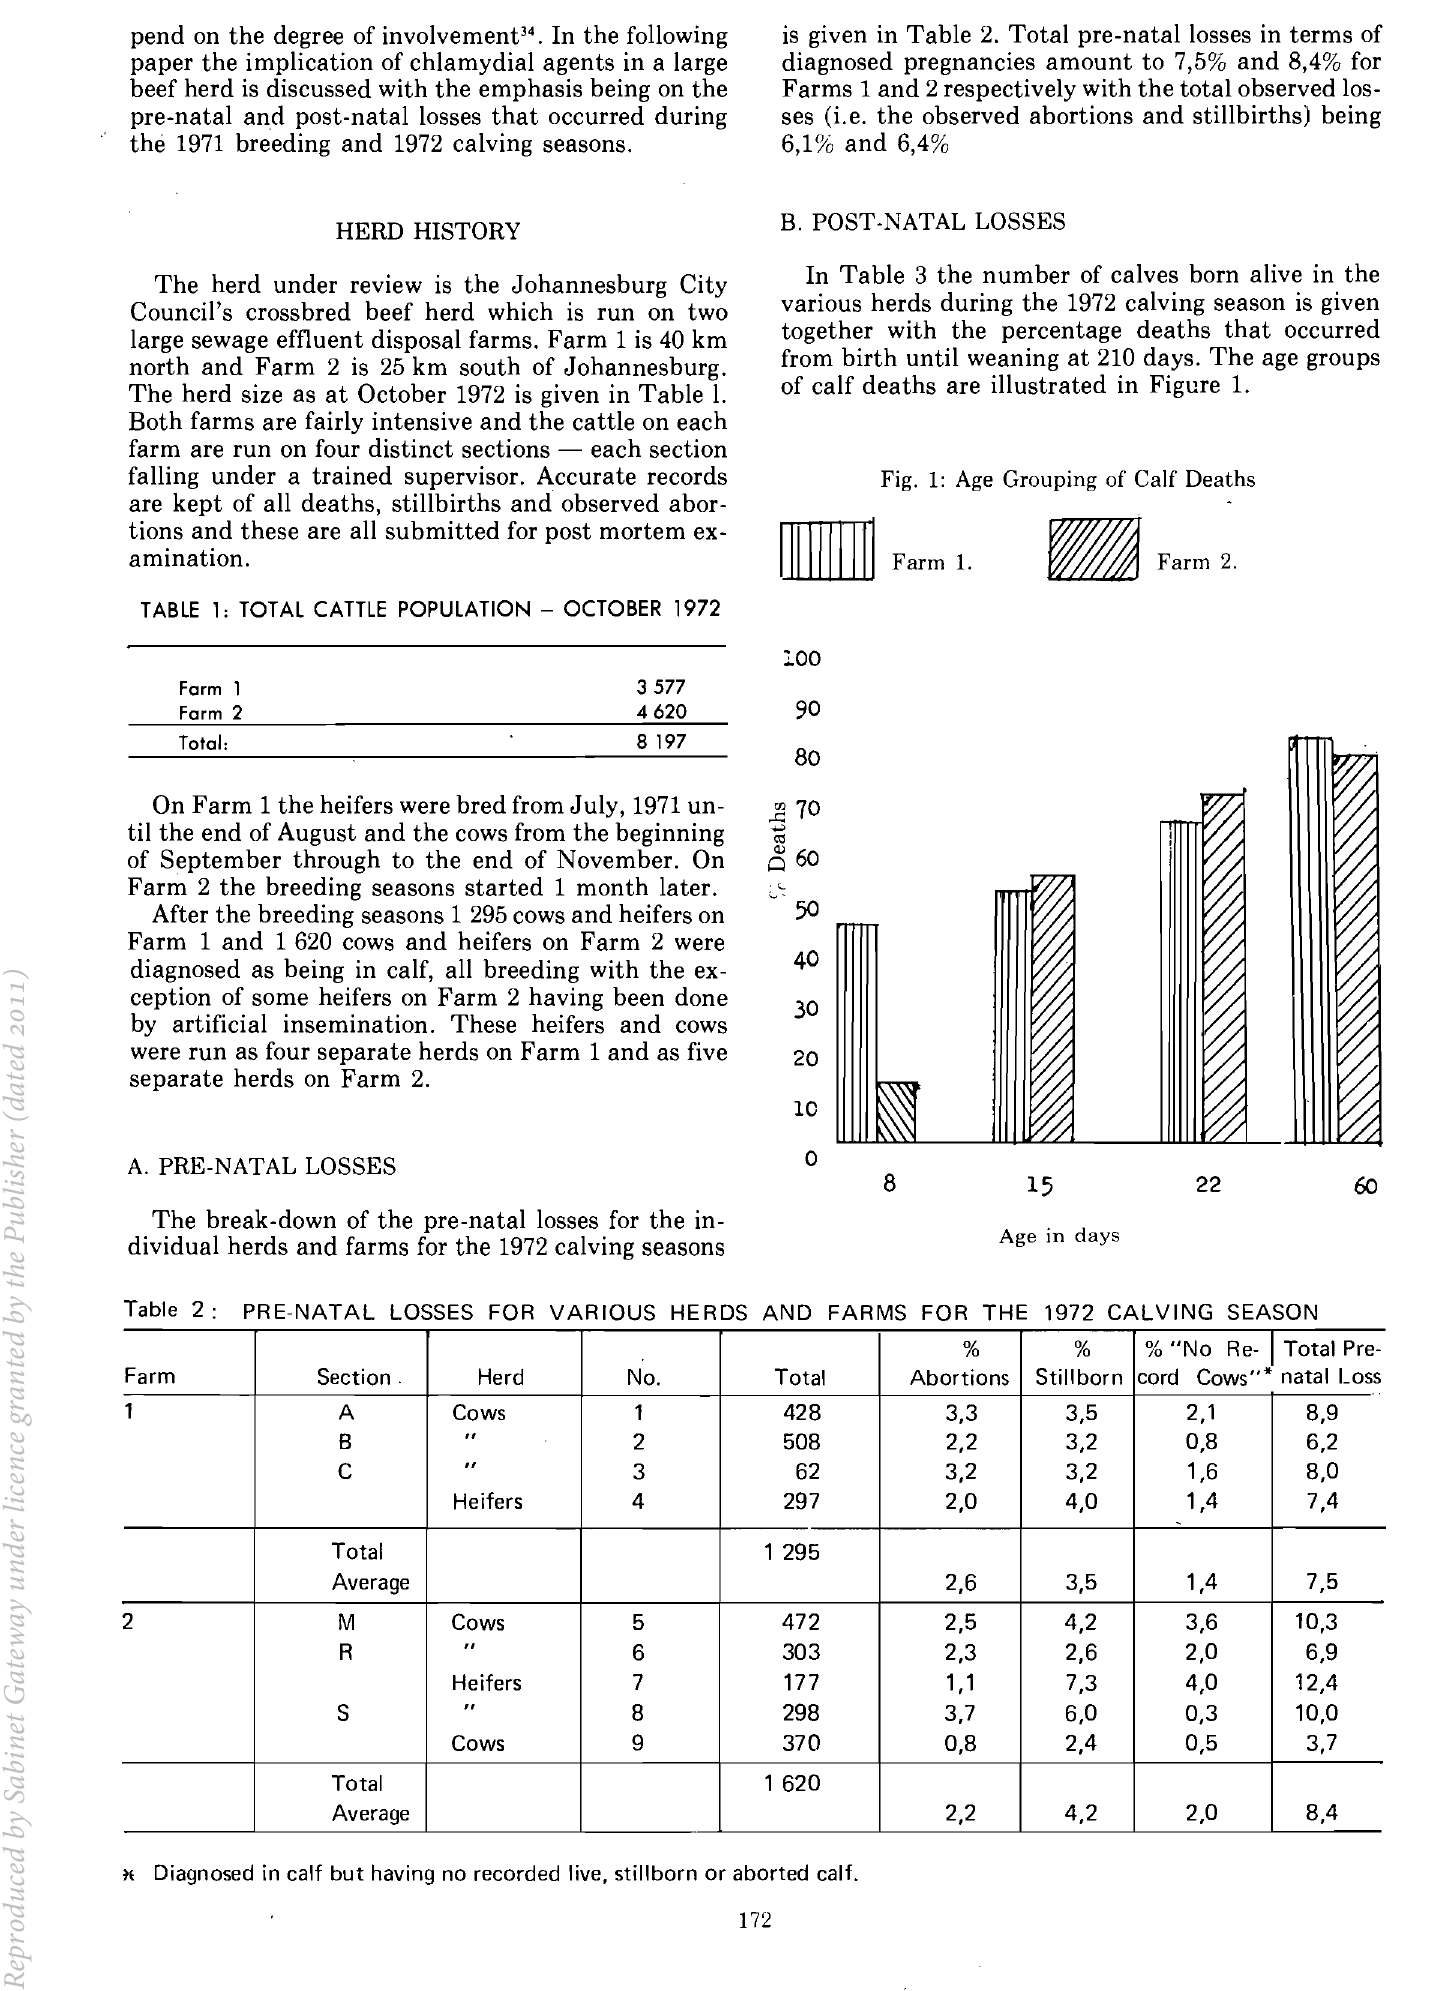
Fig. 1: Age Grouping of Calf Deaths IJIIII]]] Farm 1. . . Farm 2.